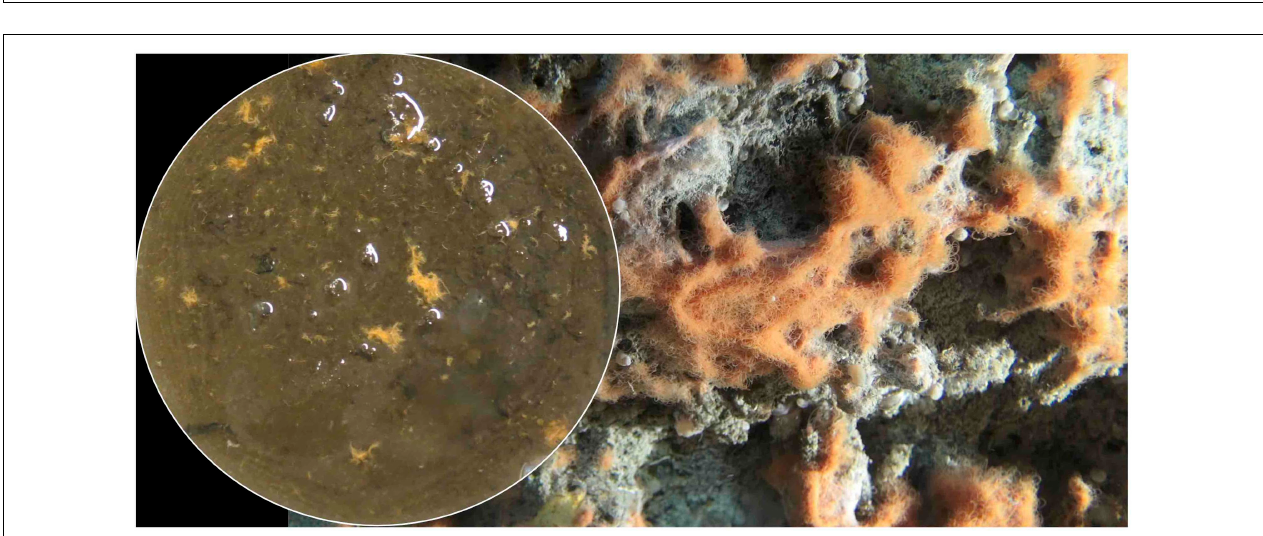
FIGURE 10 | Close-up video still of Guaymas Basin sediment surface with orange Beggiatoaceae mats, obtained with the down-facing Alvin camera during dive 4872 (December 24, 2016). The contrasting insert shows the surface of sediment core 4868-7 in the lab after gradual thawing, and pipetting off supernatant. Insert and video still image were adjusted to approximately the same scale based on individual orange Beggiatoaceae filaments with diameters of ca. 30–40 micrometers.